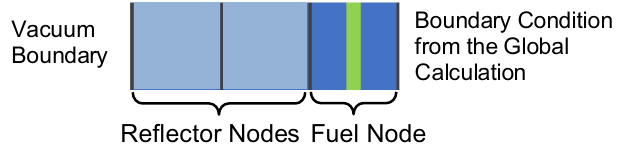
Figure 7. Extended Assembly Calculation for the Reflector Nodes (Shown for Left End of the Core)